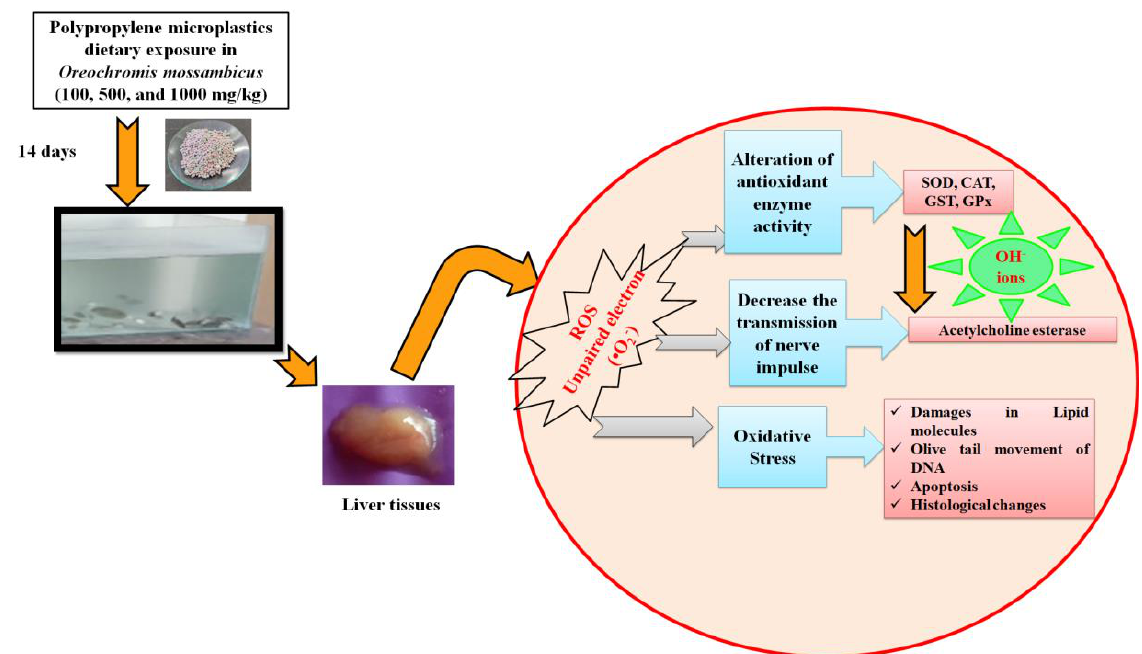
Figure 8. Interaction of polypropylene microplastics and antioxidant system of O. mossambicus toxicological pathway and their proposed mechanisms based on the outcome of this study.